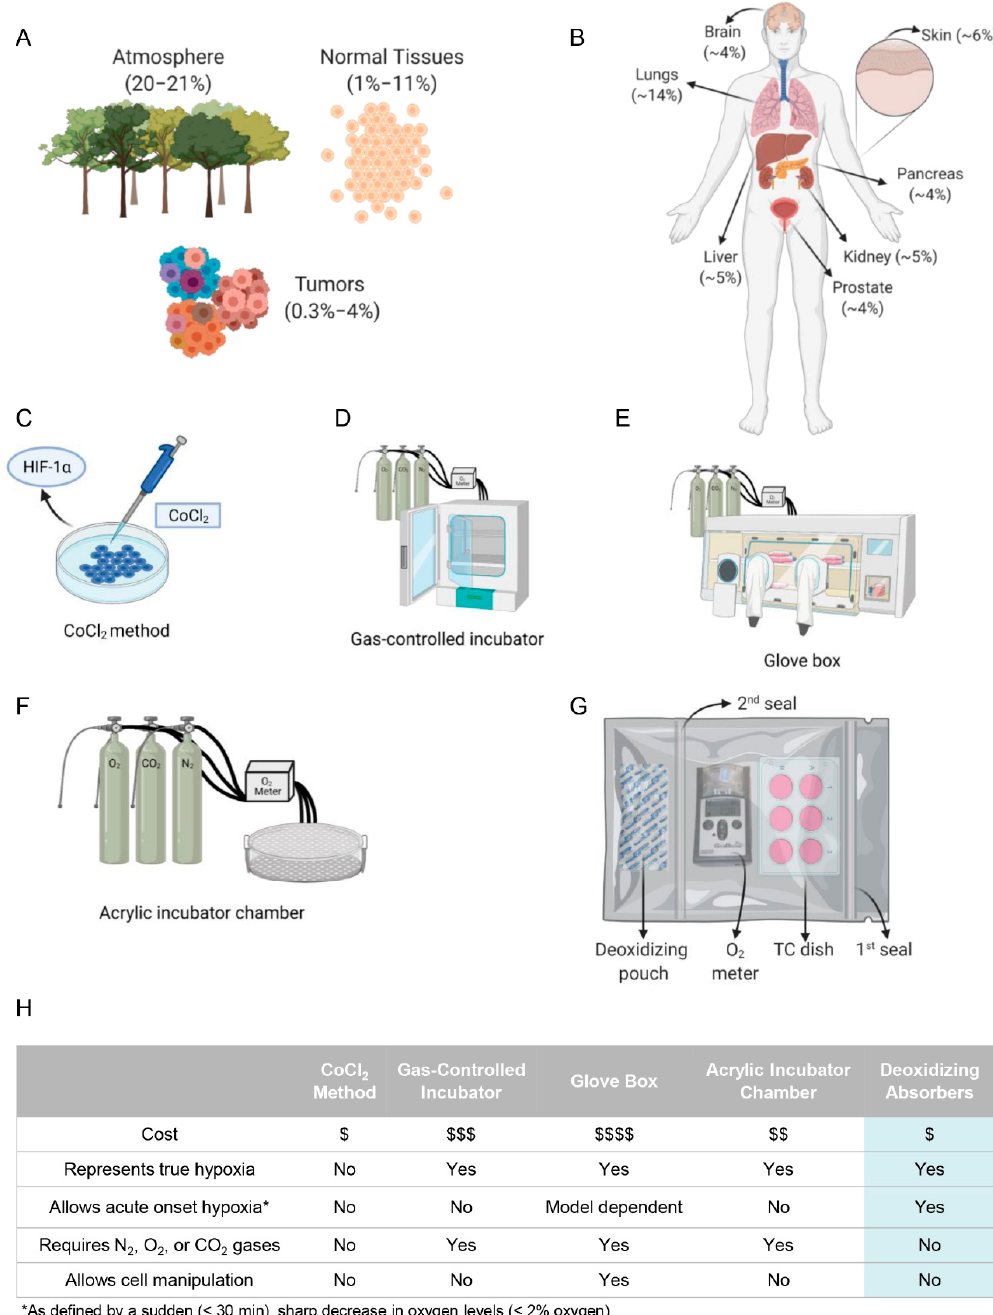
Figure 1. Available methodology to recapitulate in vitro oxygen levels found in the atmosphere, normal tissues, and tumors. ( A ) The schematic representations illustrate the oxygen concentration of atmospheric oxygen concentration (20.8%), as well as healthy tissues (1–11%) and tumors (0.3–4%). ( B ) Physoxic concentrations vary among the body tissues. The different oxygen concentrations are shown in parenthesis. ( C – G ) Many methods have been used to induce hypoxia. Cobalt chloride ( C ) is a method to achieve a chemically induced pseudo-hypoxia, whereby HIF-1 α is upregulated to mimic hypoxia without truly adjusting the oxygen concentration. Gas-controlled incubator ( D ), glove boxes ( E ), acrylic incubator chambers ( F ), and here the use of deoxidizing absorbers ( G ) represent current methodologies that utilize nitrogen and carbon dioxide gas to achieve hypoxia. ( H ) Each methodology for achieving hypoxia, including the one we present in this manuscript, has benefits and limitations as shown in the table.